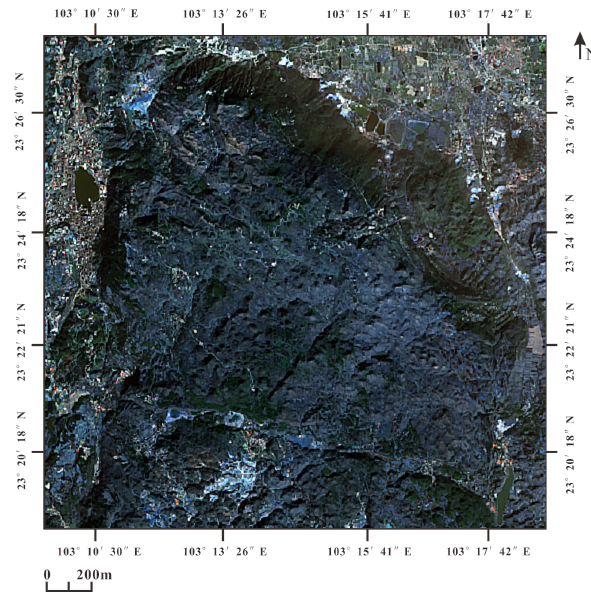
Figure 6. Enhancement of the remote sensing image.